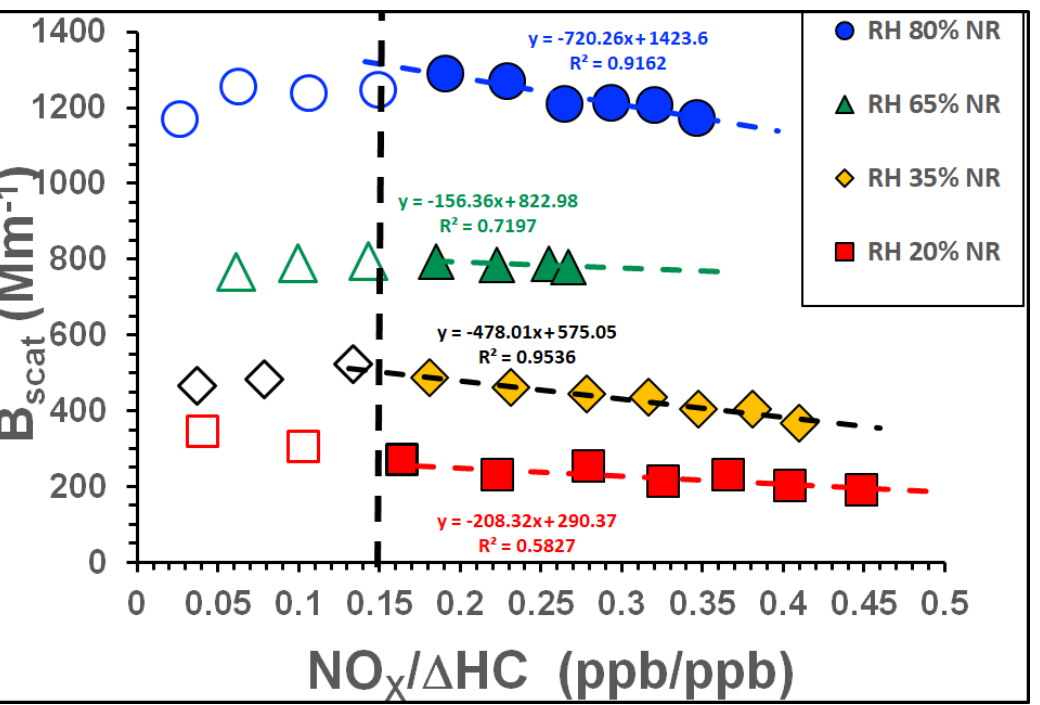
Figure 6. B scat as a function of the NOx to reacted toluene ratio ([NOx]/[ HC]) at 80% RH, 65% RH, 35% RH and 20% RH. Empty and filled symbols show results for NP and NR SOA, respectively. The dashed lines are included to guide the eye.